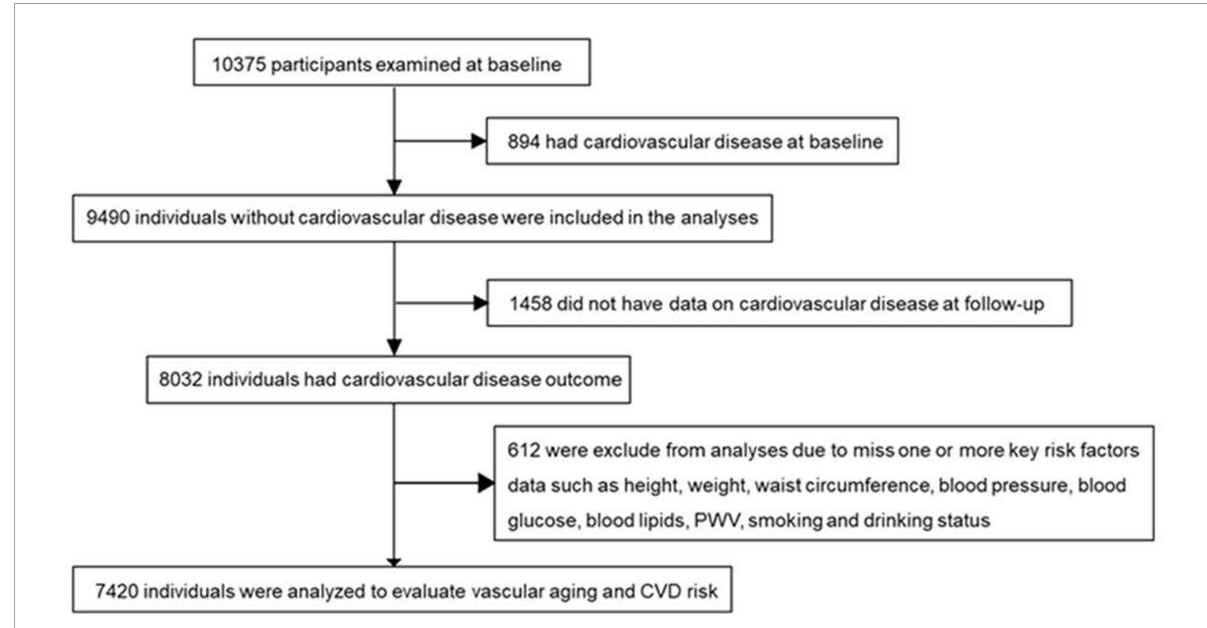
FIGURE1 Participants flow diagram. CVD, cardiovascular disease; PWV, pulse wave